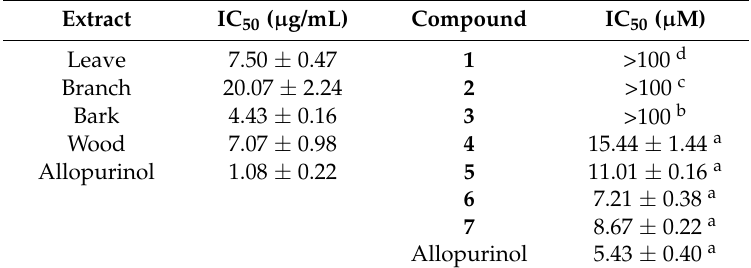
Table 2. IC 50 values for NBT/superoxide scavenging activity from different parts of QG plants and from isolated compounds.